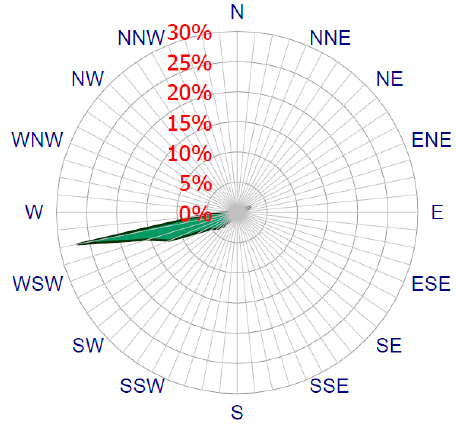
Figure 3. Wind Rose based on energy.